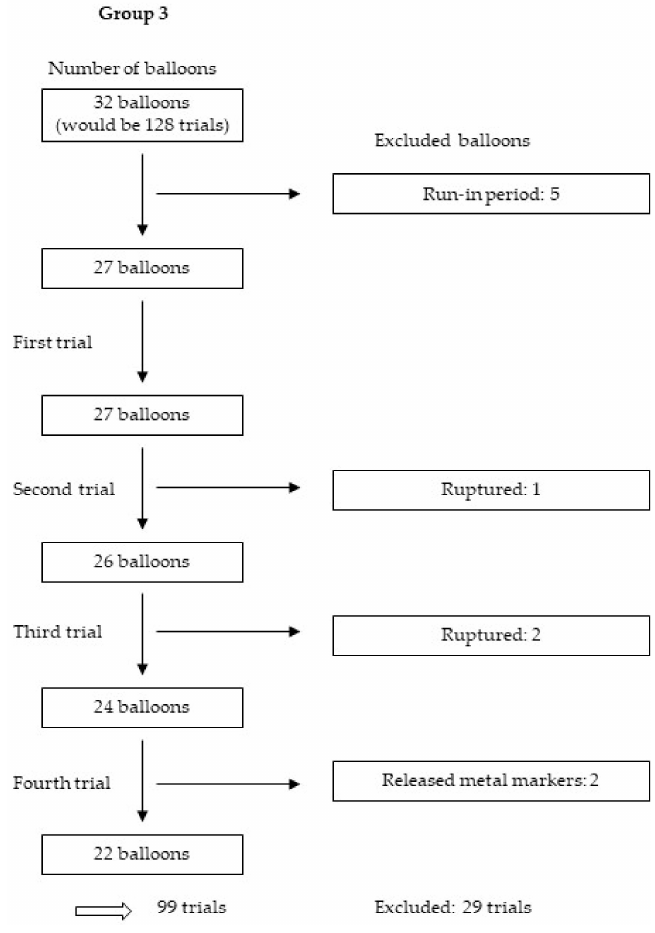
Figure 7. Excluded balloons group